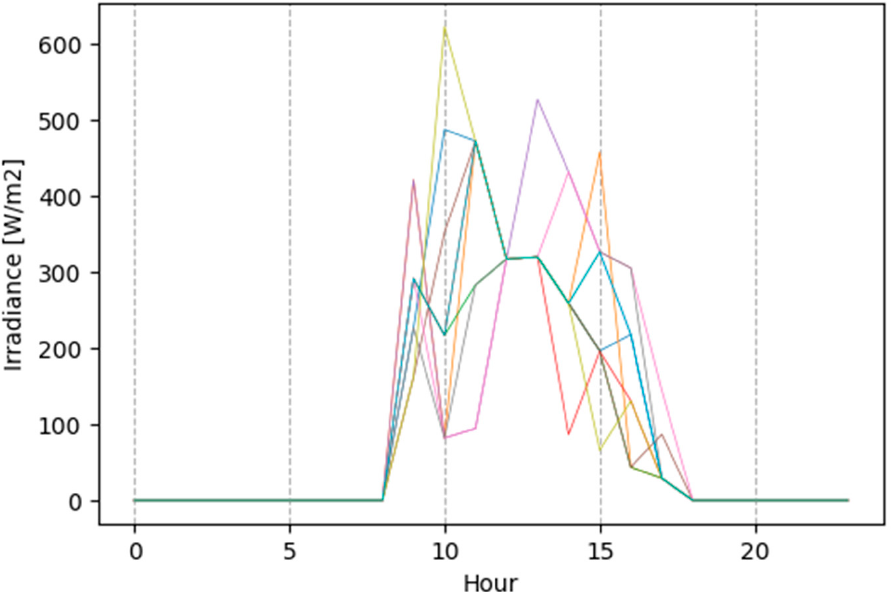
Figure 14. Ten generated scenarios reduced from one thousand initial scenarios using Fast-Forward algorithm with 7 regions, (cid:96) 2 -Norm metric, and without outlier removal. The historical data are related to January for the city of Turin (Italy) from 2005 to 2016. Different line colors represent different scenarios.